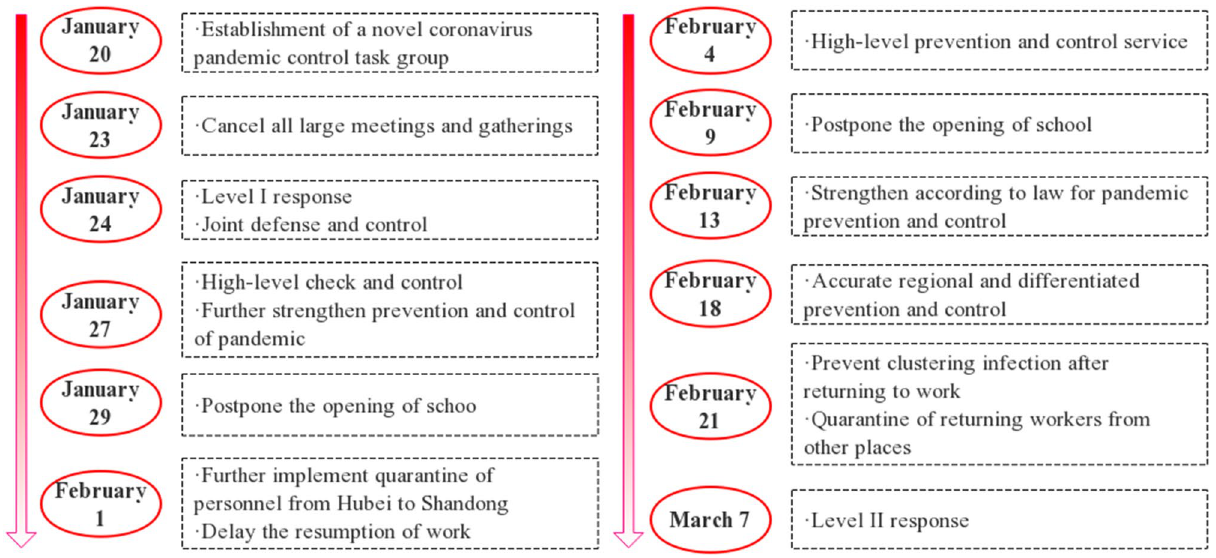
Figure 8. Evolution of COVID-19 epidemic prevention and control policies in Shandong